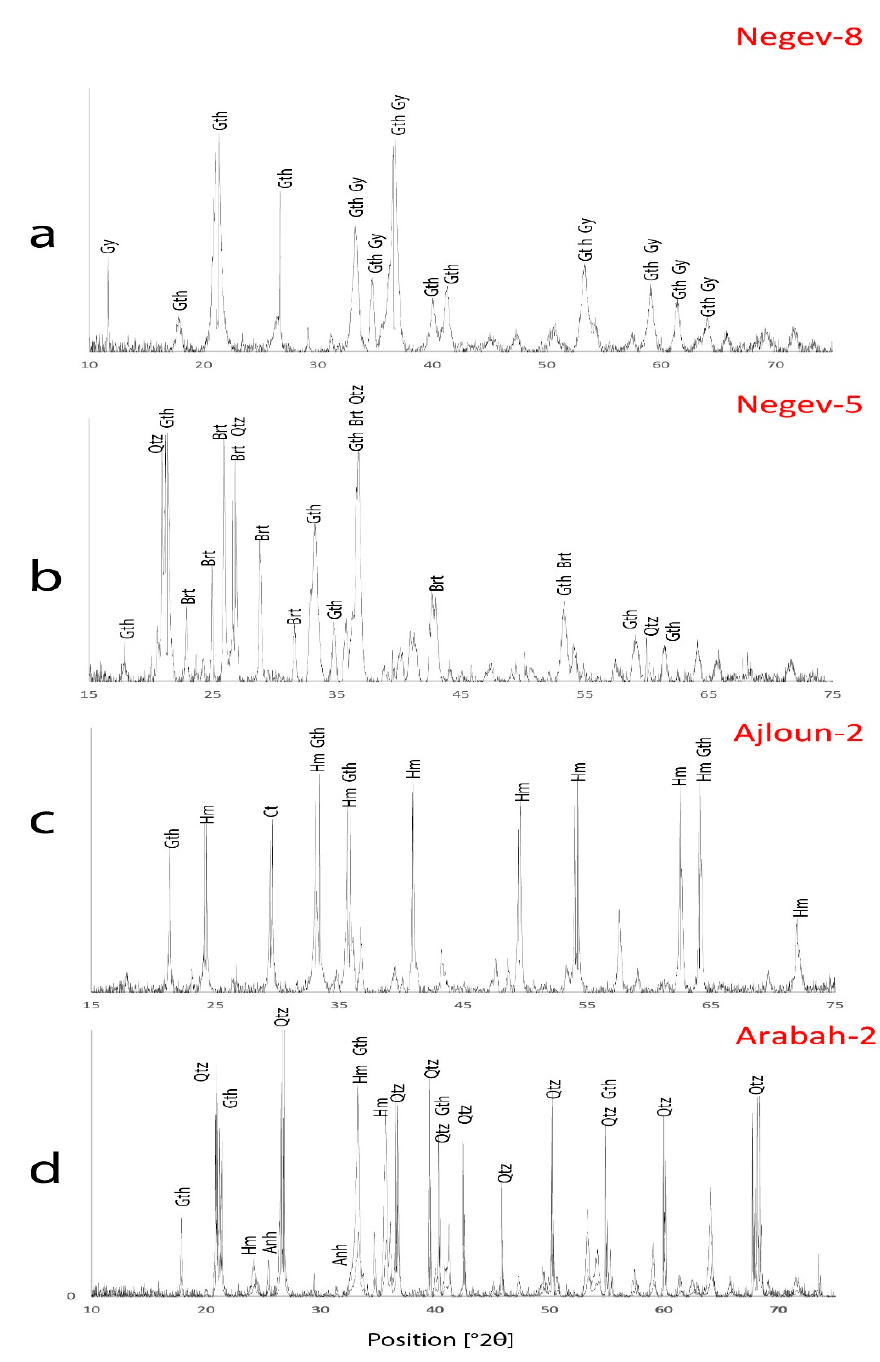
Figure 4. Examples of XRD diffraction patterns of analyzed iron ore samples with peaks corresponding to specific minerals: ( a ) Negev-8. Ore dominated by goethite (Gth) with some amount of gypsum (Gy); ( b ) Negev-5. Ore dominated by goethite with some amount of barite (Brt) and quartz (Qtz); ( c ) Ajloun-2. Ore dominated by hematite (Hm), with some amount of goethite and calcite (Ct); ( d ) Arabah-2. Ore of goethite and hematite, with significant amount of quartz and minor amount of anhydrite